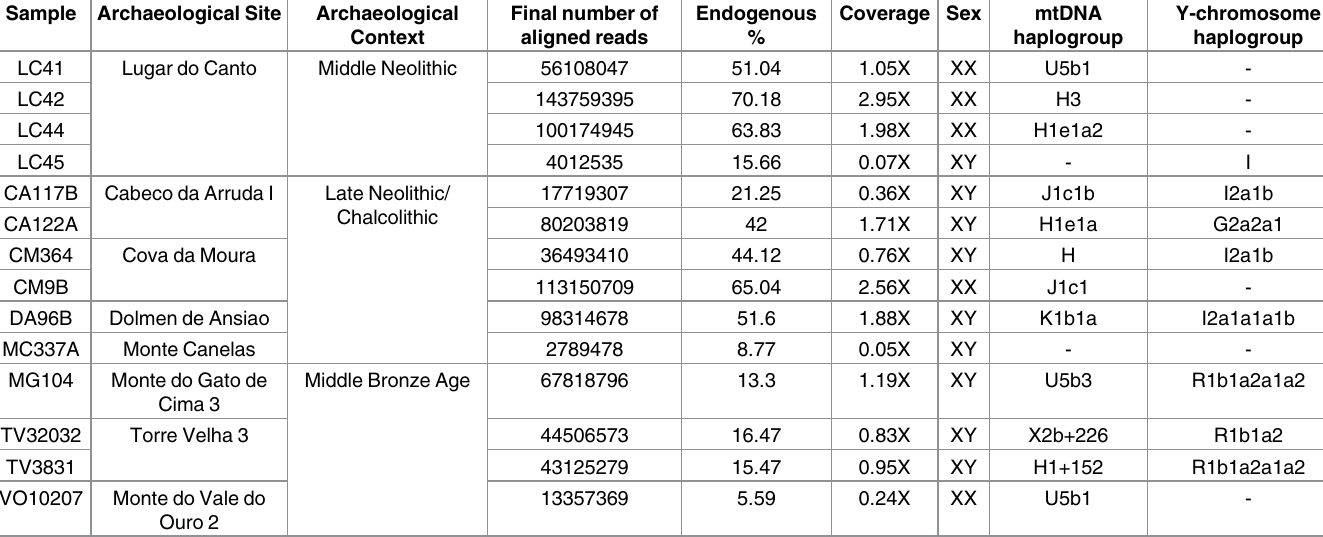
Table 1. Summaryof the samples sequenced in the present study.